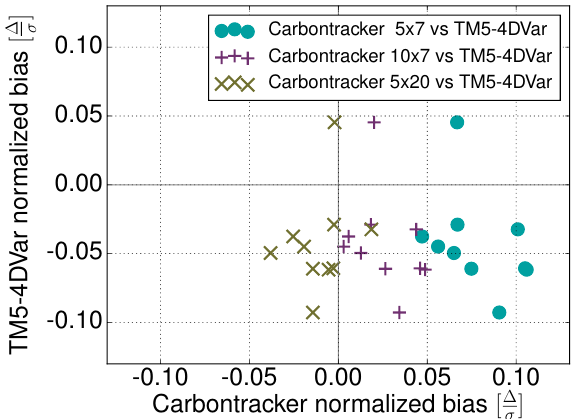
Figure 5. Model–measurement bias of TM5-4DVar against Carbon- Tracker for non-assimilated measurement sites. Each symbol corre- sponds to a case resampling exercise where the biases are calcu- lated for 25 randomly drawn sites out of the total 50 resampling sites listed in Table S1 in the Supplement. The baseline run (dots) is compared to a CarbonTracker run with the assimilation period ex- tended to 5 × 20 days ( × ) instead of 5 × 7 days and 10 × 7 days ( + ).